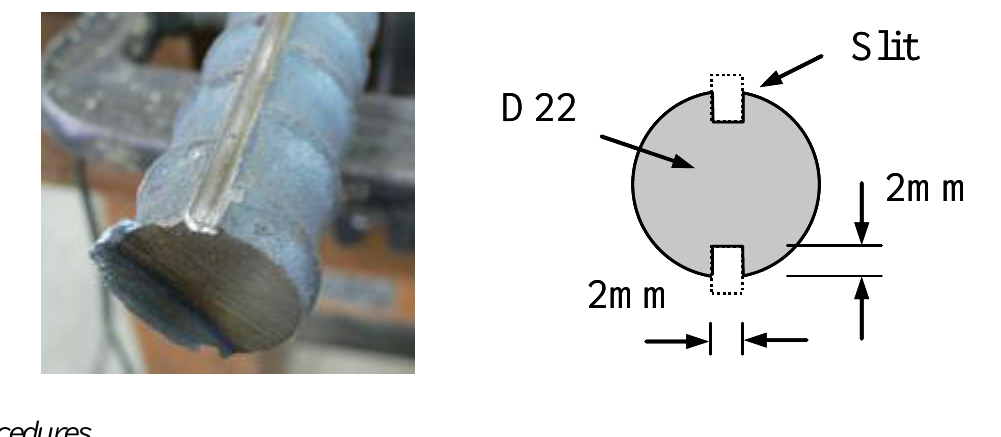
Figure 7. Slits in rebar for ink